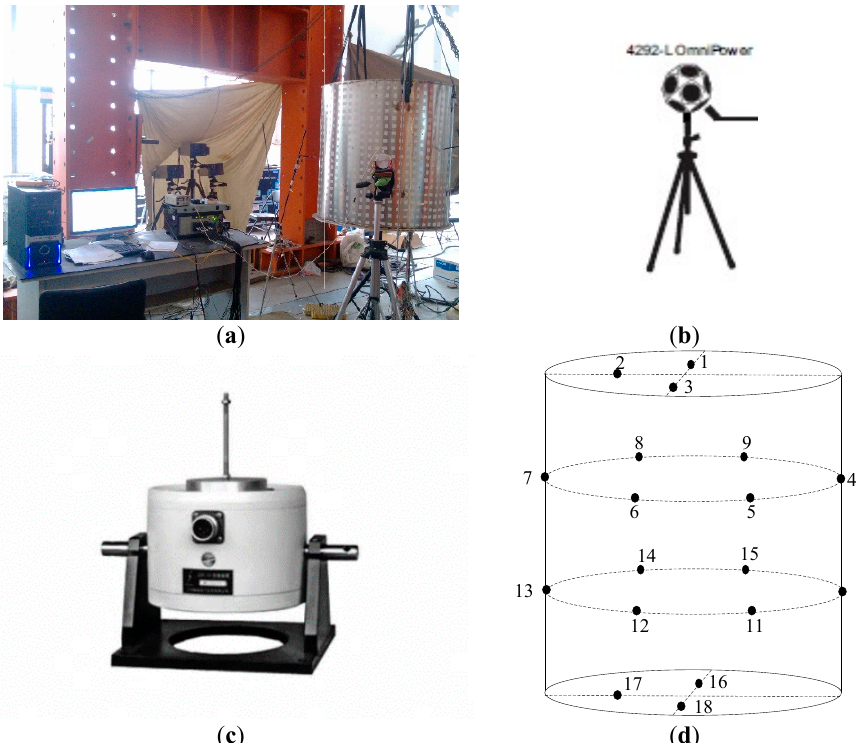
Figure 3. ( a ) Acoustic and vibration experimental devices. ( b ) Acoustic excitation. ( c ) Vibration excitation source. ( d ) Vibration response point layout diagram.